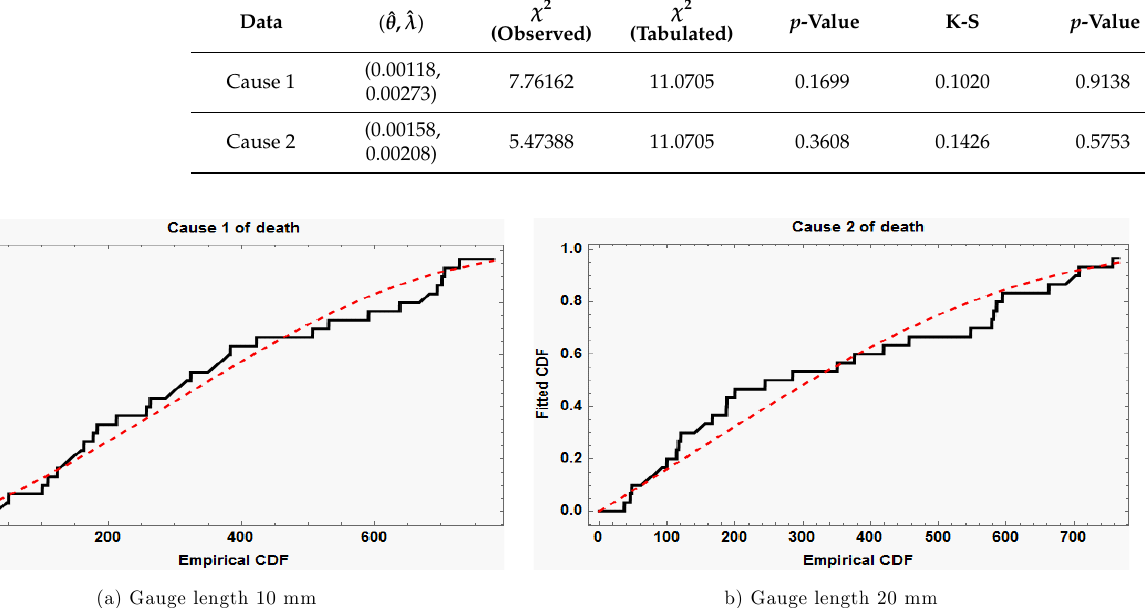
Figure 6. Empirical cumulative distribution functions (Black lines) and fitted parametric cumulative Fig. 6. Empirical cumulative distribution functions (Black lines) and (cid:133)tted parametric cumulative distribution functions (red dashed lines) distribution functions (red dashed lines) for the data from Xia et al. (2009). Panels ( a , b ) represent the for the data from Xia et al. (2009). Panels (a) and (b) represent the cause 1.and cause 2 of death, respectively. cause 1 and cause 2 of death,